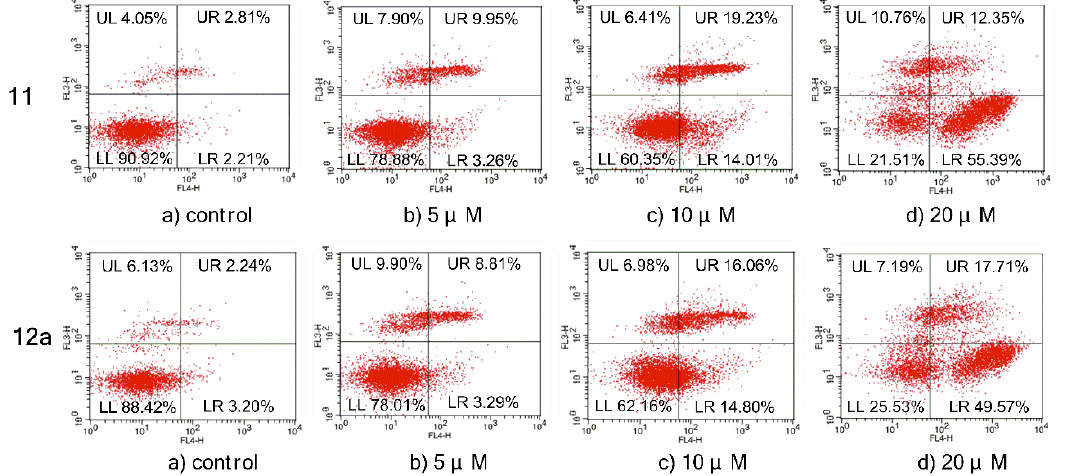
Figure 5. Apoptosis ratio detection by Annexin V-APC/7-AAD double staining assay, analyzed by a flow cytometry on MCF-7 cells treated with compound 11/12a for 72 h, respectively. The UL area represents damaged cells appearing in the process of cell collection, the UR area represents necrotic cells and later period apoptotic cells, the LR area represents early apoptotic cells, and normal cells are located in the LL area.